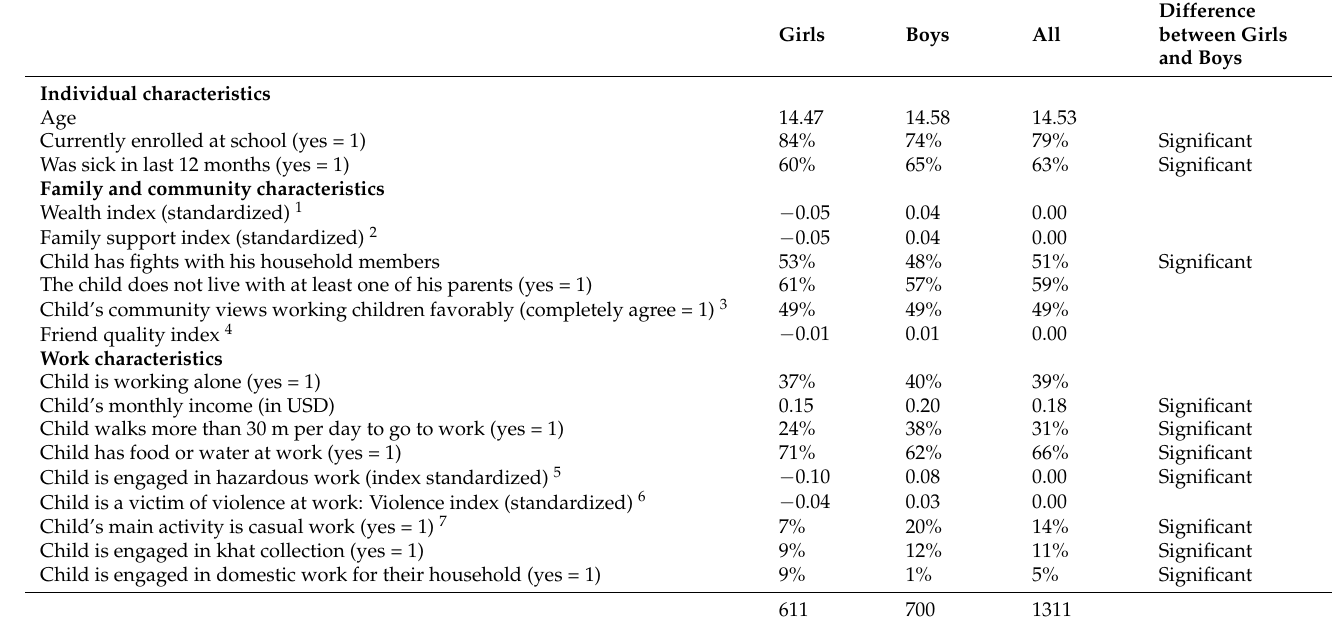
Table 1. Characteristics of the